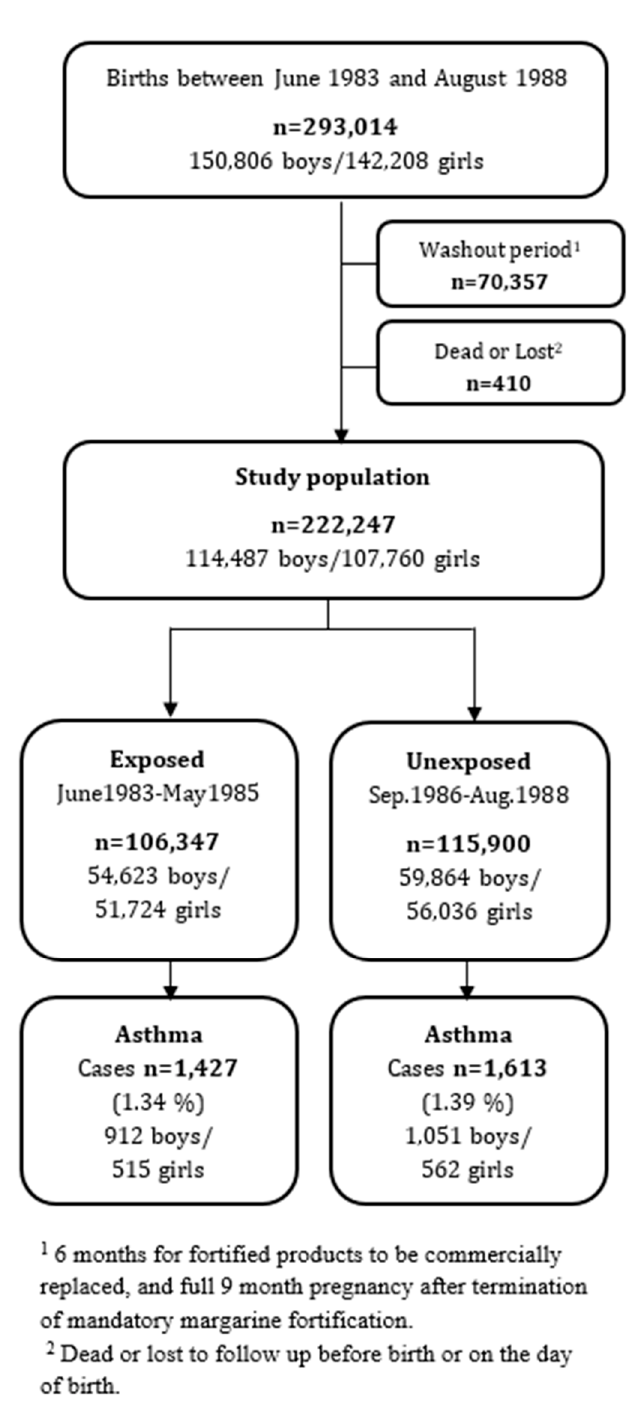
Figure 2. Flowchart of the study population.